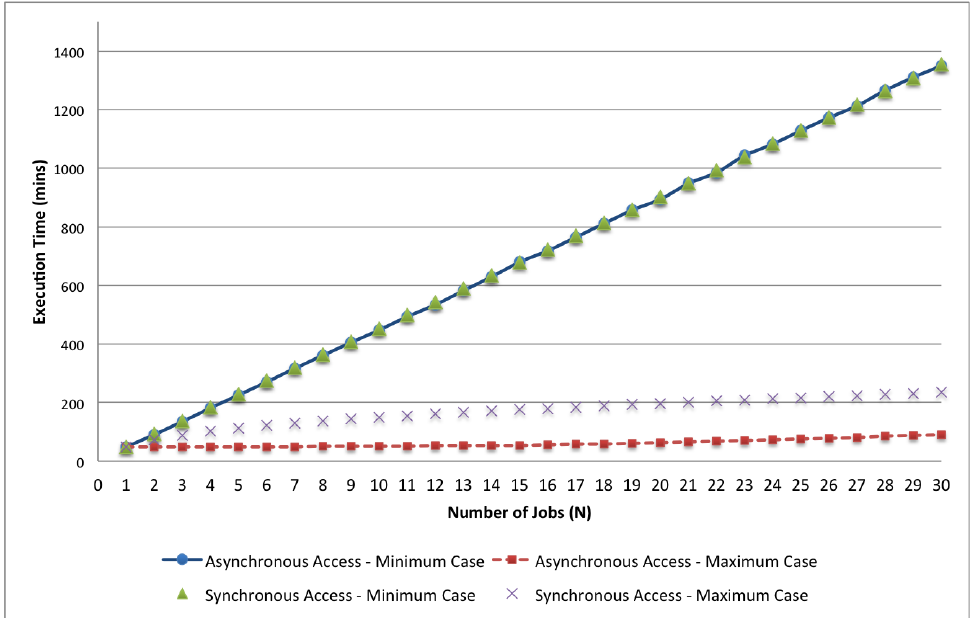
Figure 12. Bounds on execution